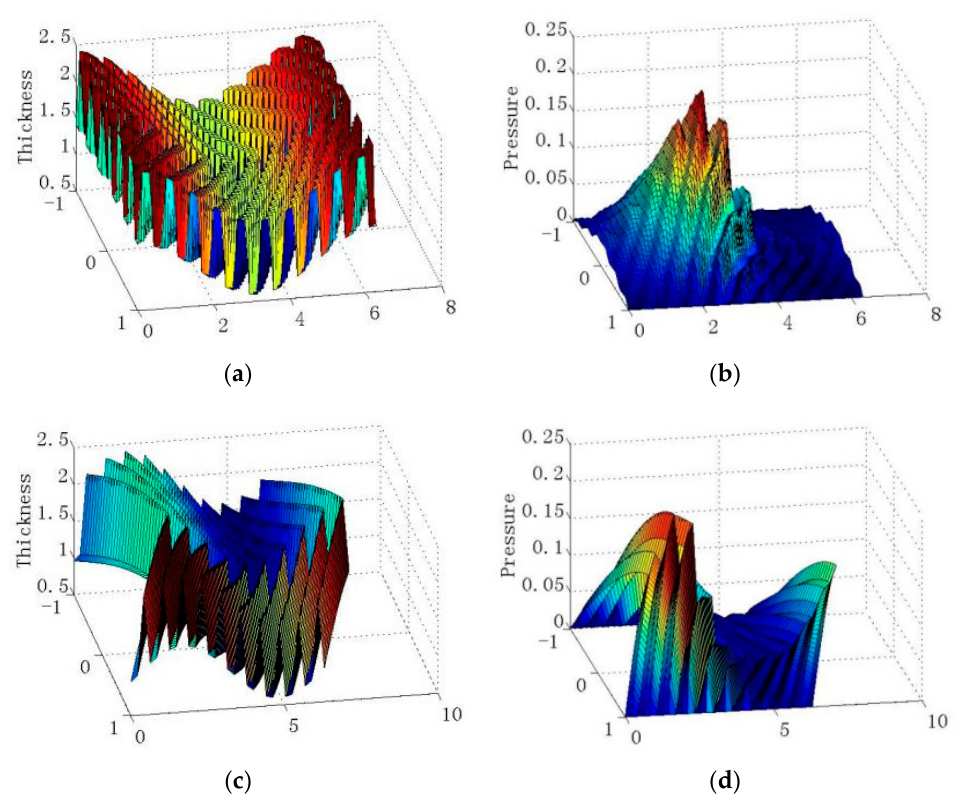
Figure 8. Oil film thickness and pressure distributions in different coordinate systems: ( a , b ) are calculated in CCS; ( c , d ) are calculated in OCS.